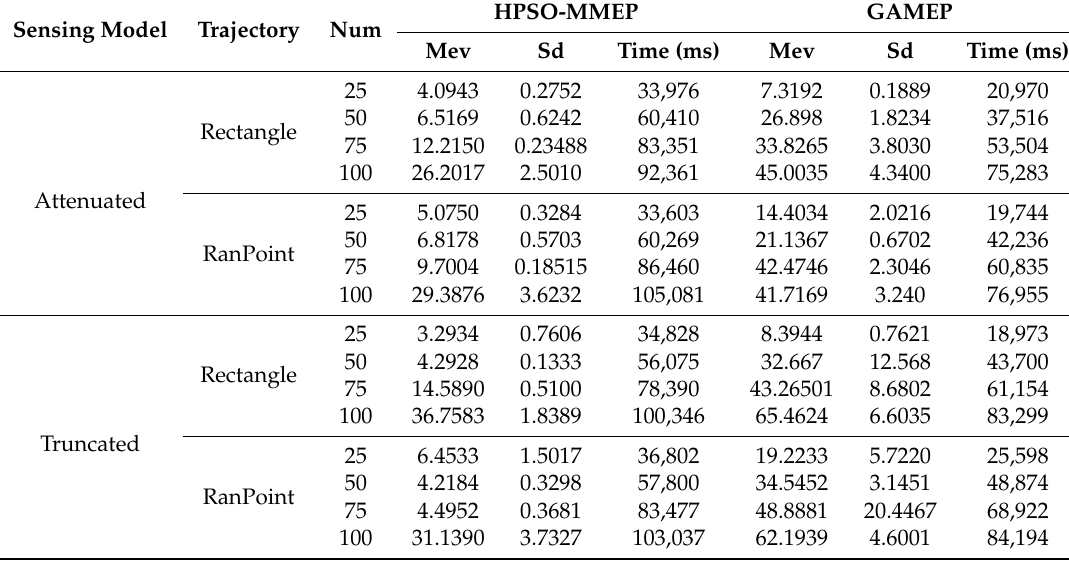
Table 6. Computation results of HPSO-MMEP in comparison with GAMEP in uniform distribution of sensors (Mev: minimal exposure value, Sd: standard